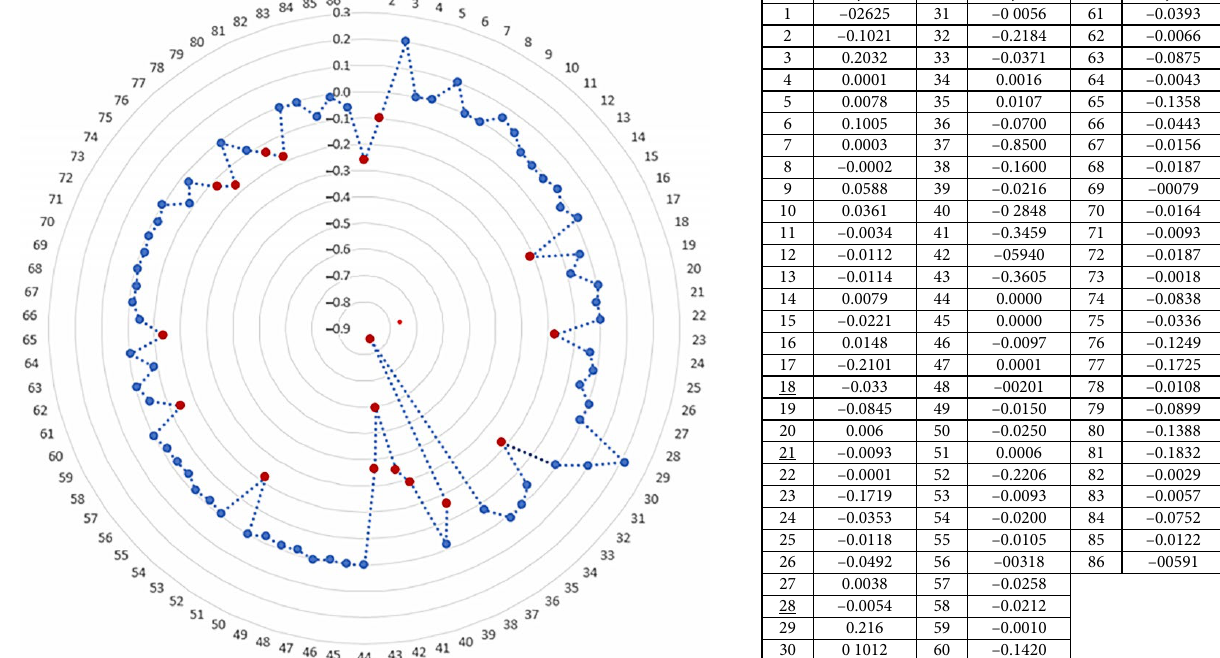
“Parkis”Figure 5. Trustworthiness index T i ( n ) of the respondents calculated by applying the proposed PROMETHEE-MGQNN